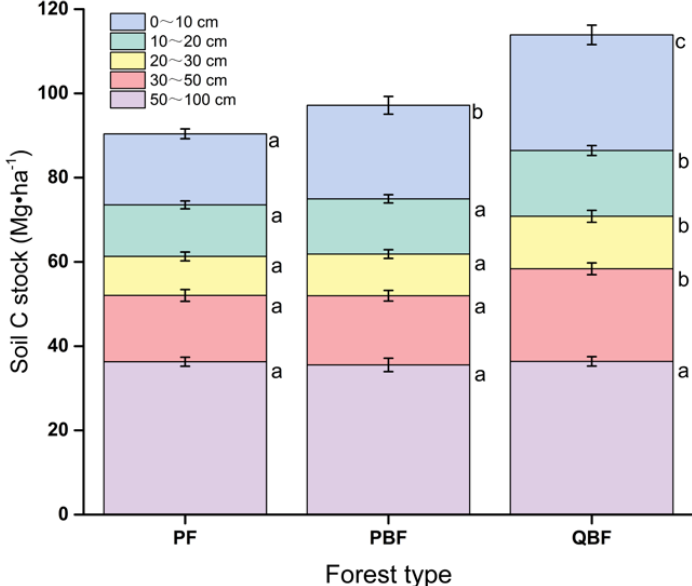
Figure 4. The soil carbon stocks of the various soil layers in the pure Pinus tabuliformis forest (PF), pine-broadleaved mixed forest (PBF) and Quercus -broadleaved mixed forest (QBF) in the central Loess Plateau of China. a, b, and c indicate significant differences in the carbon stocks of the same components at different succession stages at p = 0.05.